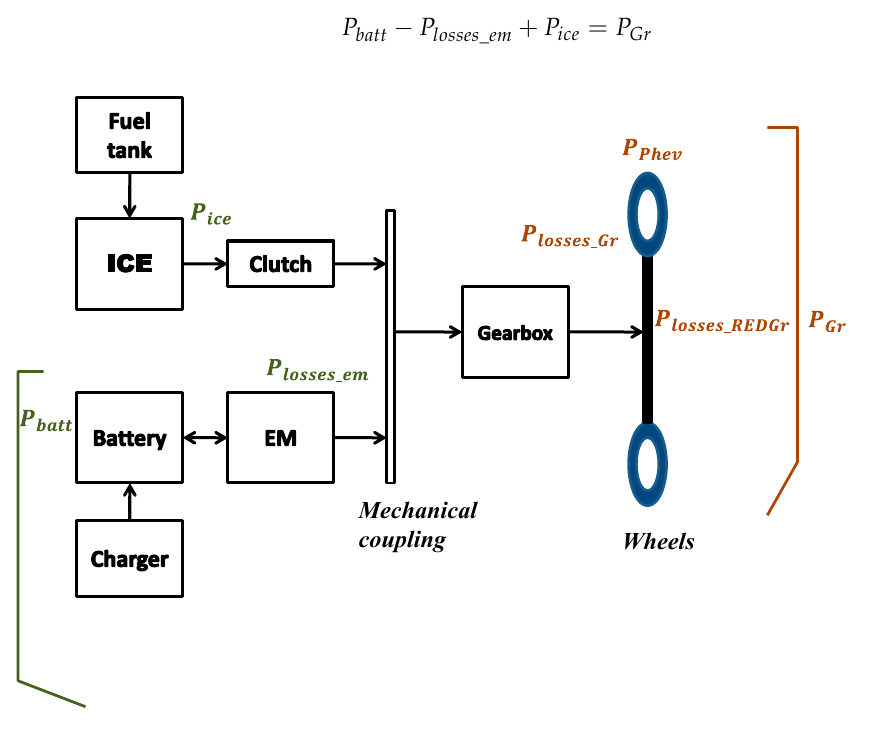
Figure 9. Input/output power energy for a parallel PHEV Topology.